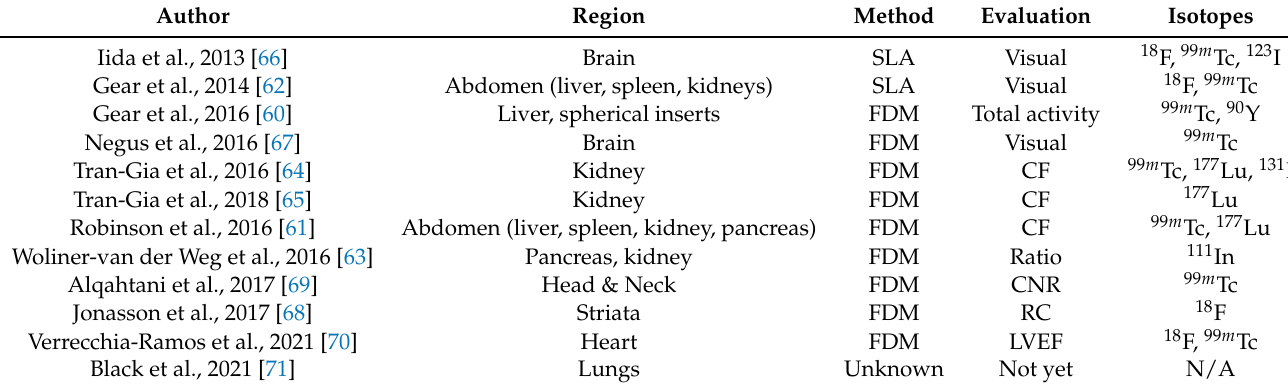
Table 1. Summary of all articles and phantoms included in this review. SLA = stereolitography, FDM = Fused Deposition Modelling, CNR = contrast-to-noise ratio, RC = recovery coefficient, CF = calibration factors, LVEF = left ventricular ejection